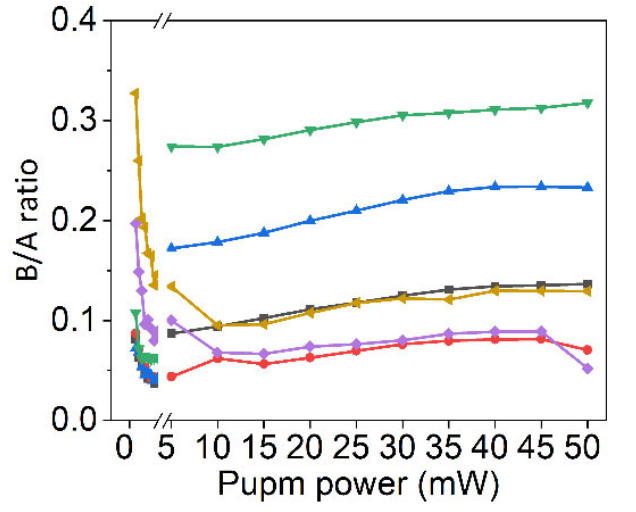
Figure 6. The variation of the B/A intensity ratio of 6 selected sites from the same sample after keeping in air for 6 months. The B/A ratios raised form different sites are labeled by different colors.